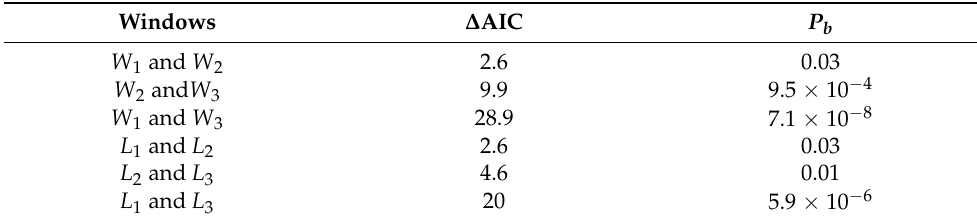
Table 1. Results of the P parameter test between